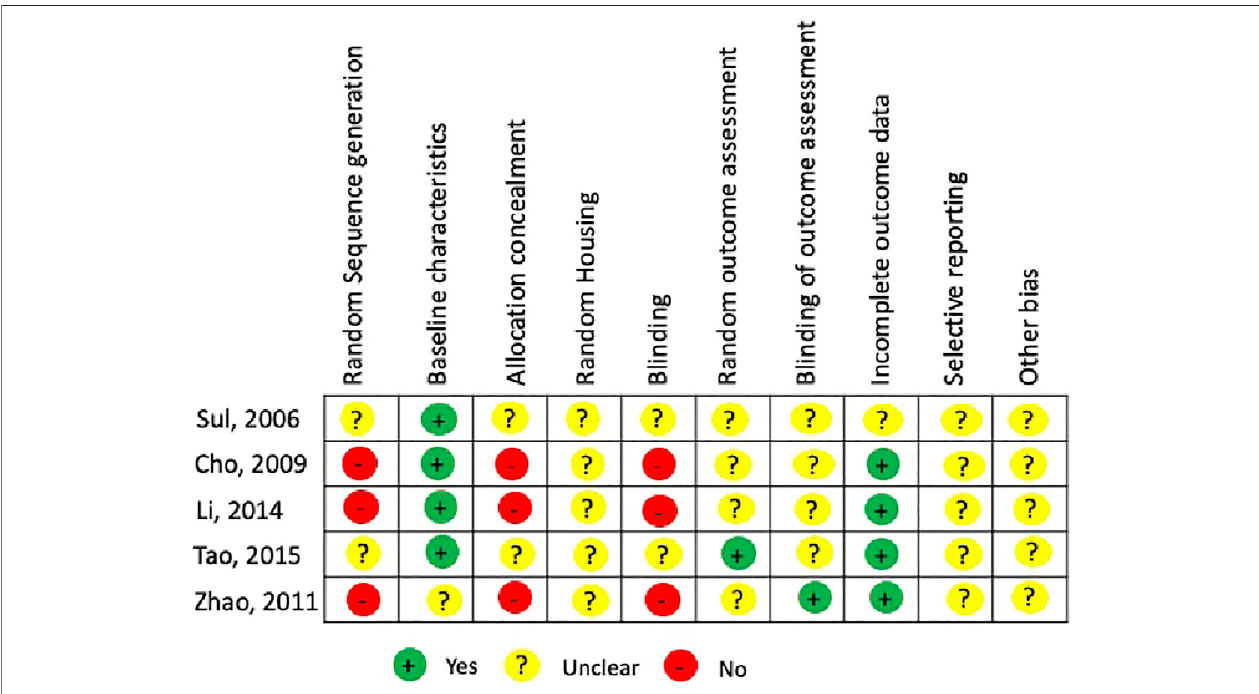
FIGURE 2 | Risk assessment using SYRCLE RoB tool for individual animal experimental studies included in the systematic review.